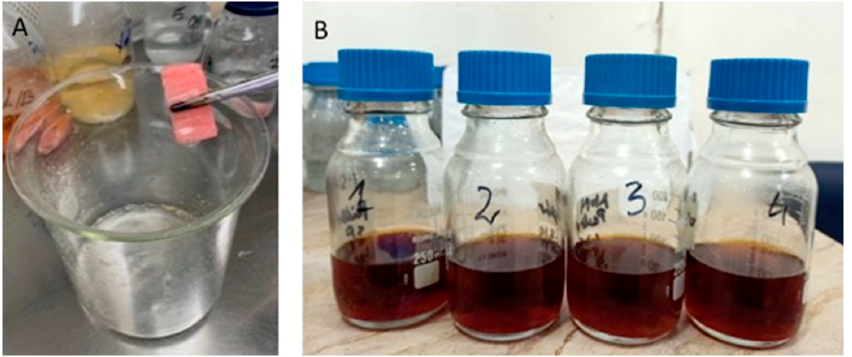
Figure 2. ( A ) Acquisition of PMMA samples after bacterial incubation. ( B ) Incubation of PMMA samples for 24 h, 36 h, 48 h and 96 h.